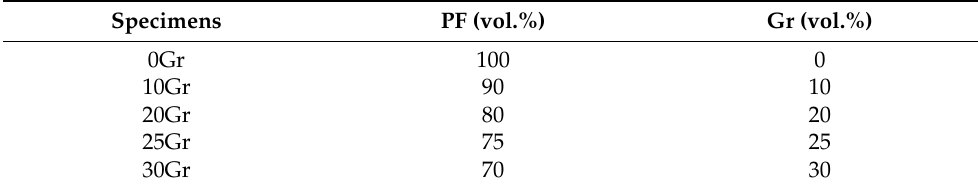
Table 1. The composition of friction materials in the volume